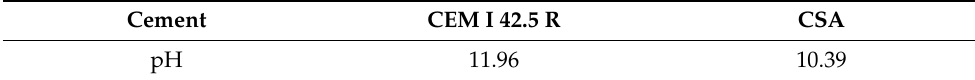
Table 6. Water extract pH of MSWIBA mortars with CEM I 42.5 R and CSA.